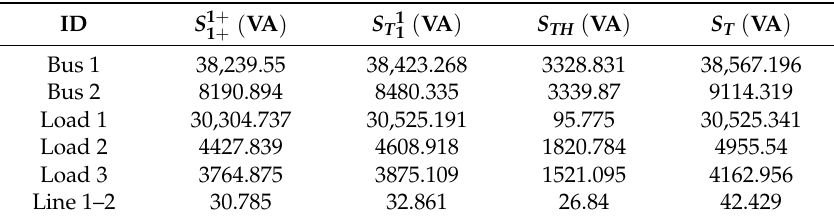
Table 11. Summary of apparent power